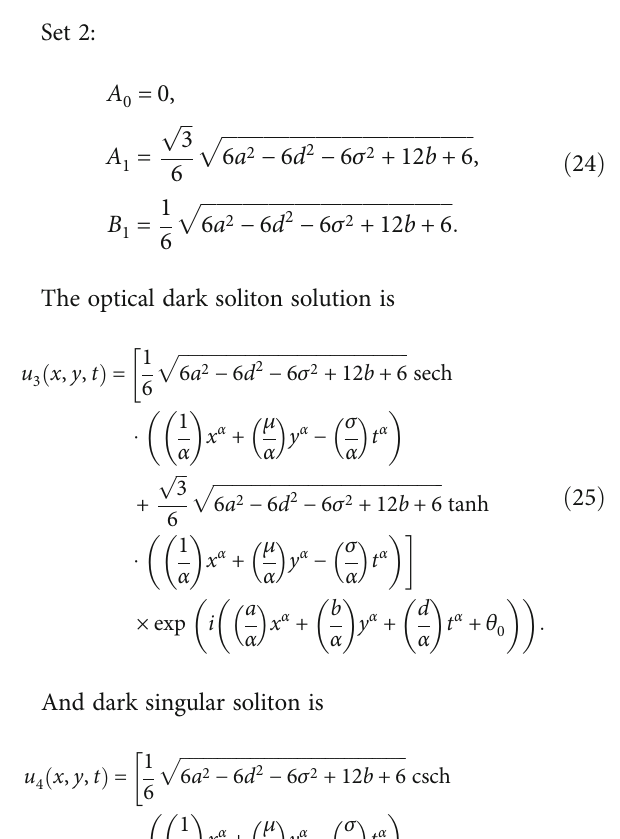
Figure 4: Graphical representation of solution u (23) for t = 0 :: 5, x = − π :: π , for α = 0 : 8